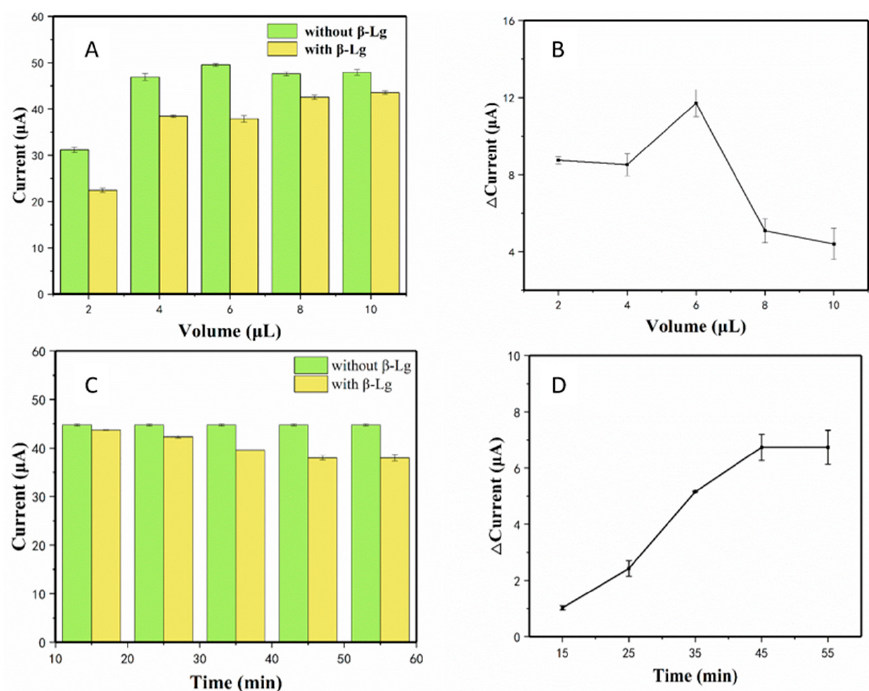
Figure 5. Optimization conditions for β -lactoglobulin ( β -Lg) detection using the electrochemical assay: ( A , B ) the titration volume (2, 4, 6, 8, or 10 µ L) of PEI-rGO-AuNCs used to modify the electrode; ( C , D ) the incubation time (10, 15, 25, 35, 45, or 55 min) of the PEI-rGO-AuNCs electrode with β -Lg standards (0.025 ng/mL).